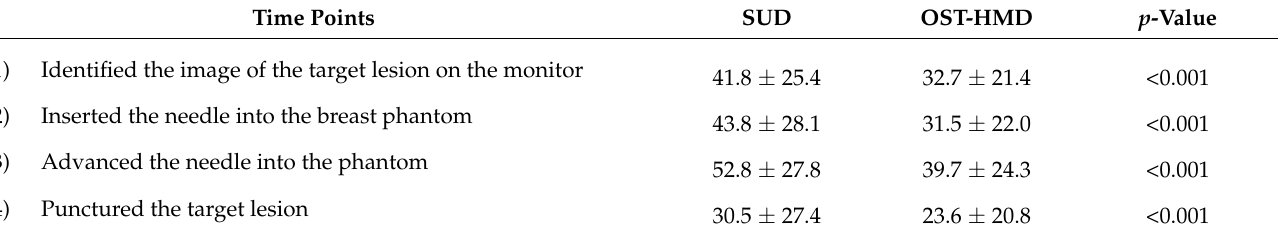
Table 3. VAS scores evaluated by the practitioners while performing the US-guided needle punc- ture procedure.